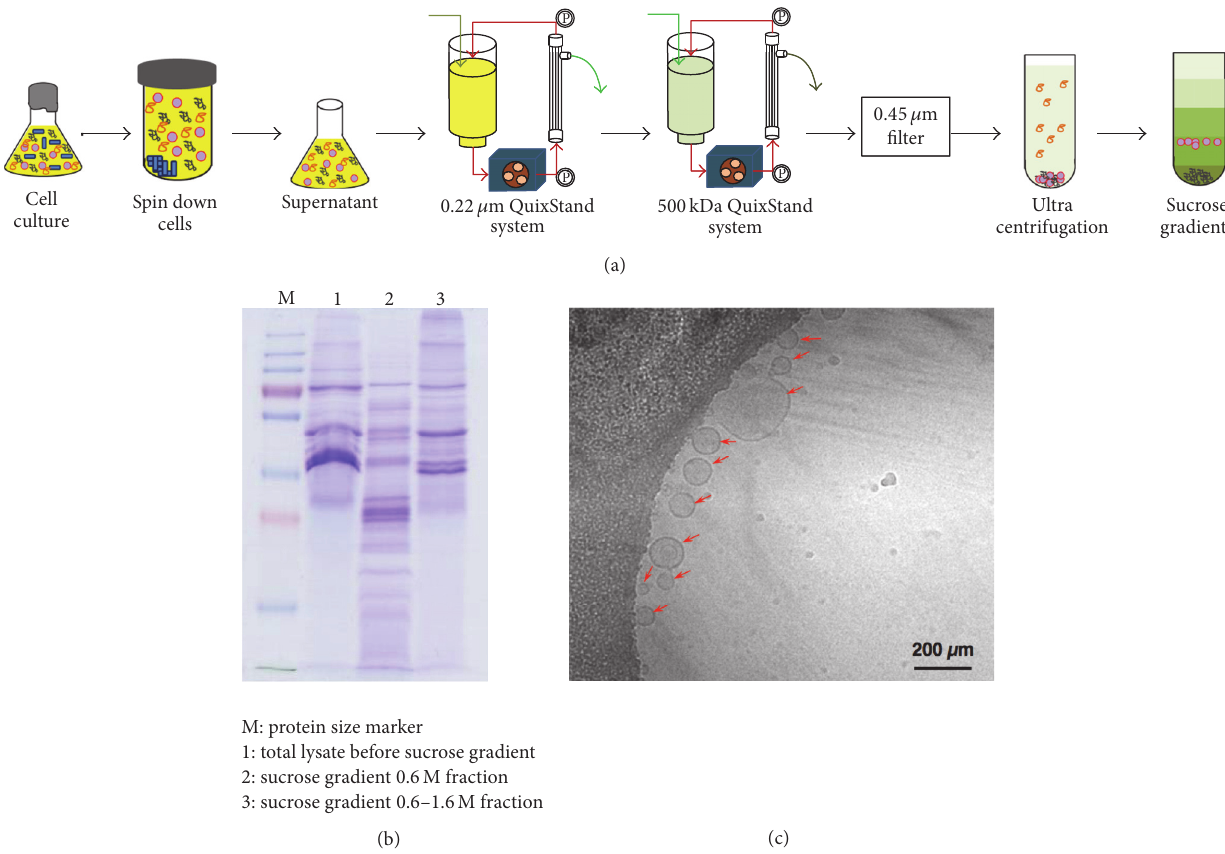
Figure 1: Purification of Streptococcus pneumoniae BAA-255 extracellular membrane vesicles (EMVs). (a) Summary of the method used to prepare S. pneumoniae BAA-255 EMVs. (b) SDS-PAGE of the EMVs before and after sucrose gradient fractionation. (c) Transmission electron microscopy of the EMVs. Red arrows indicate